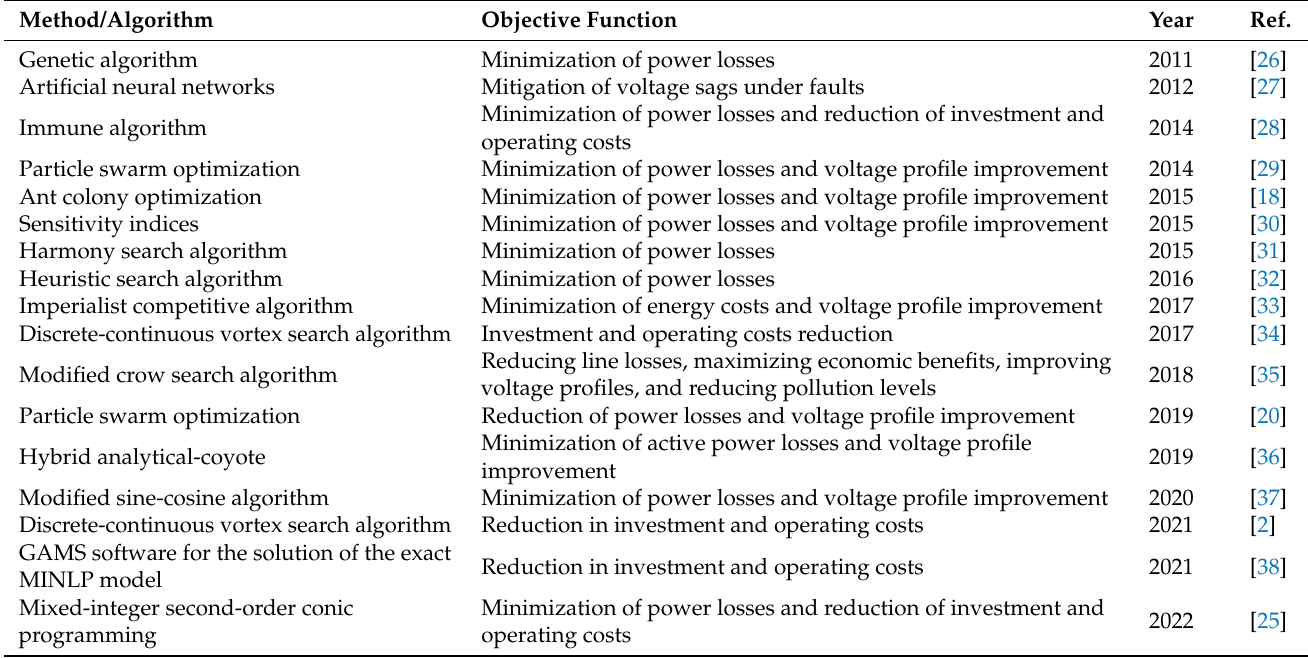
Table 1. Overview of methodologies used in the literature for sizing and locating